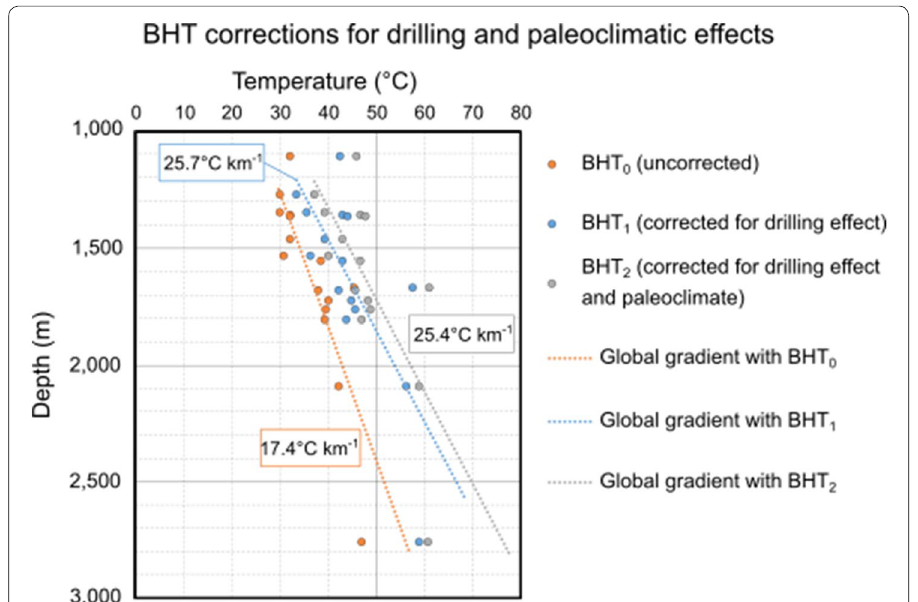
Fig. 9 BHTs correlated with depth and corrected for both drilling disturbance and paleoclimatic